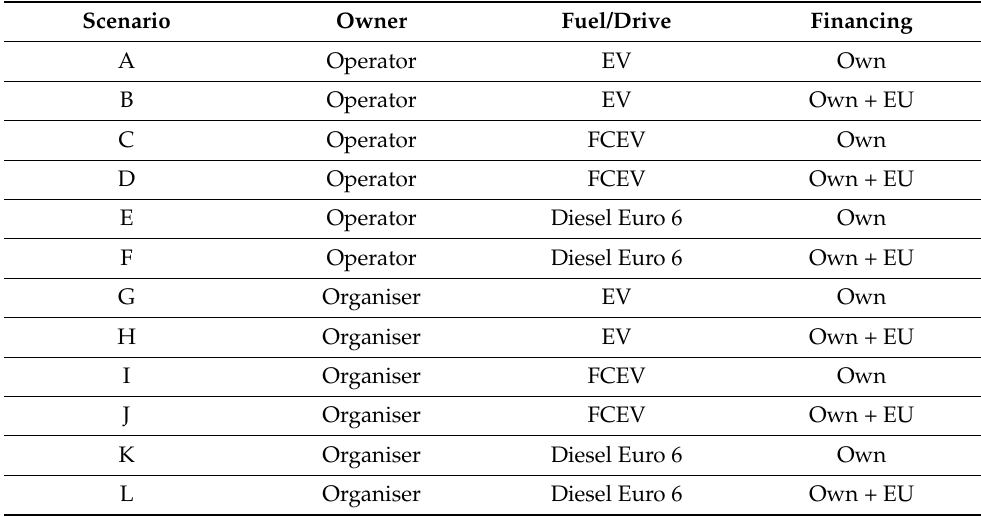
Table 3. Characteristics of